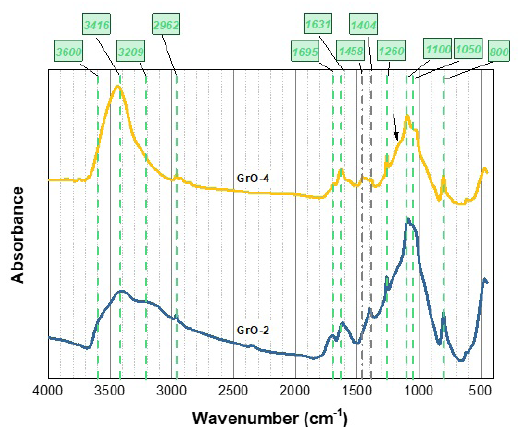
Figure 3. FTIR absorption spectra of GrO-2 and GrO-4 dry